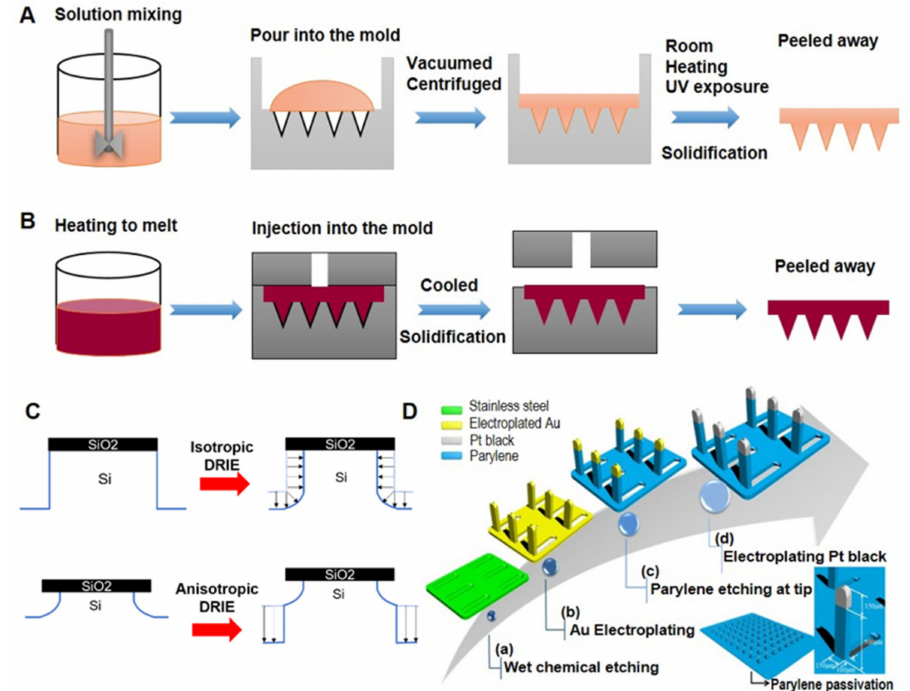
Figure 4. Fabrication processes of MNs. ( A ) The casting method includes preparing a solution mixture, pouring the solution mixture into the mould, vacuuming or centrifuging to completely fill the mould, leaving it at room temperature, heating or UV exposure for solidification, and then peeling away the prepared MNs. ( B ) Injection moulding that includes heating the sample to melt, injection into the mould, cooling to solidification, and then peeling away the prepared MNs. ( C ) Basic processing principles in deep reactive ion etching (DRIE): ( a ) Isotropic plasma etch of MNs vertical walls in DRIE etched with a high aspect ratio in a silicon substrate, ( b ) anisotropic plasma etch of the silicon dioxide mask, and ( c ) principle of the basic process for producing high aspect ratio structures in DRIE technology [118]. The figure was redrawn with some changes from Reference [118]. ( D ) Wet chemical etchant and steps of the solid MN fabrication that was surface modified with a Pt black catalytic layer for a non-enzymatic glucose sensor: ( a ) wet chemical etching in a stainless steel substrate, ( b ) Au electroplating, ( c ) Parylene etching at the tip, and ( d ) electroplating for the Pt black layer [91]. The figure was reproduced with permission (with some changes in the text of the original figure) from Reference